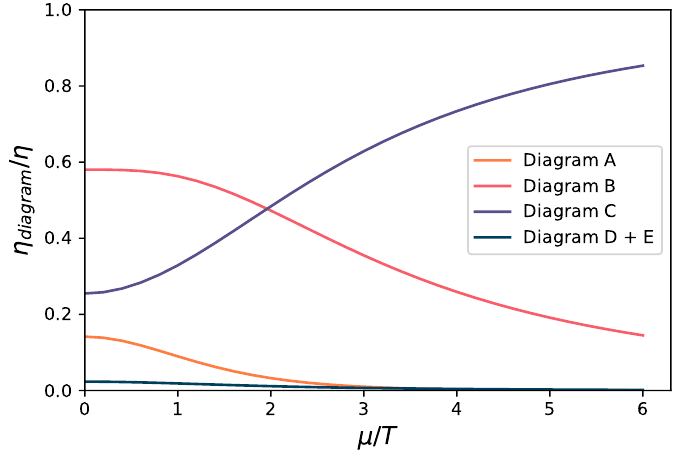
Figure 4 . Contribution from each diagram to shear viscosity, a m ˜ C (A / B / C ... ) mn a n , normalized by the sum of all contributions, as a function of chemical